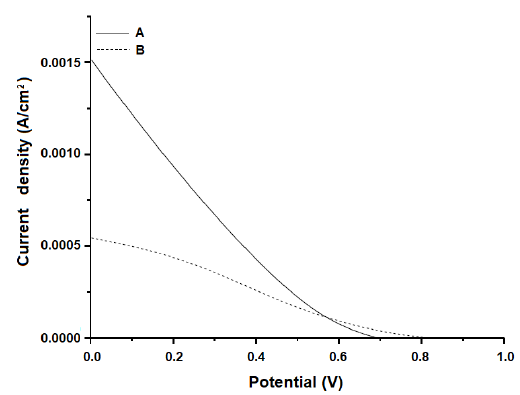
Figure 2. j x V curves of cells using non-sintered (A) and sintered (B) graphite from a pencil. Other conditions: electrolyte: tetrabutylammonium iodide (0.05M) / I (0.005M); substrate: ITO; 2 Photoanode: TiO . 2